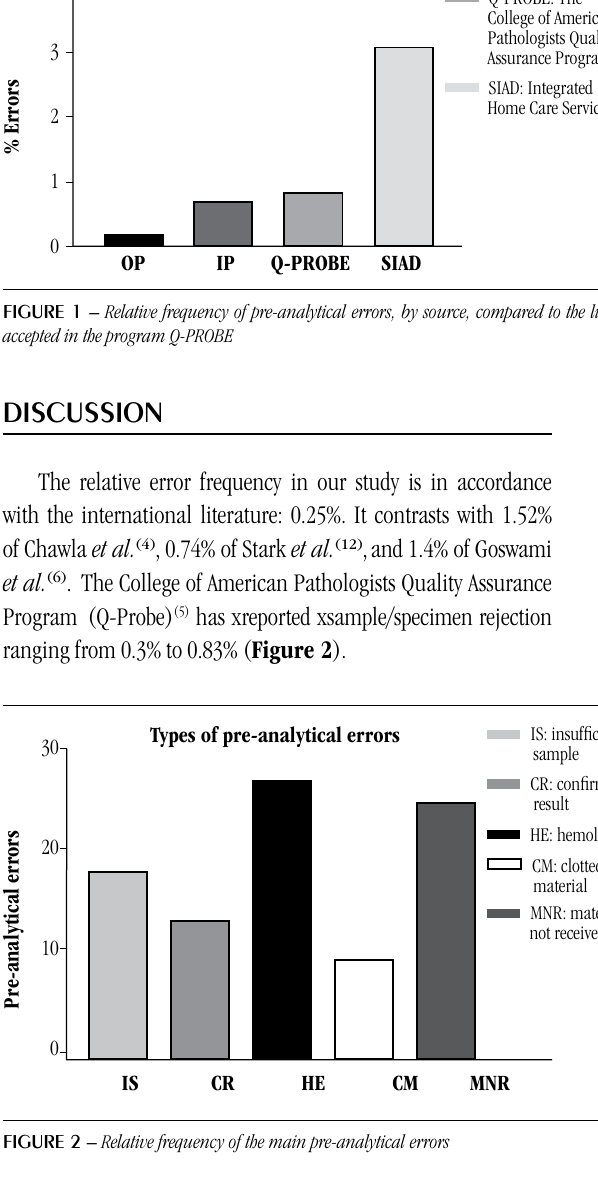
figurE 2 – Relative frequency of the main pre-analytical errors